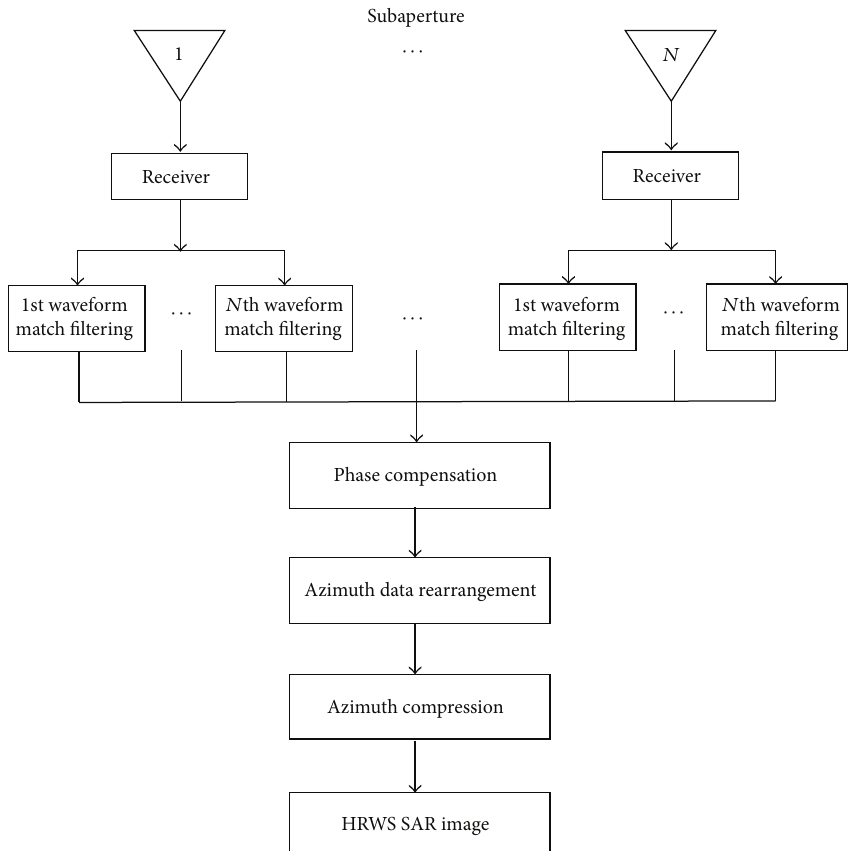
Figure 2: MIMO SAR processing